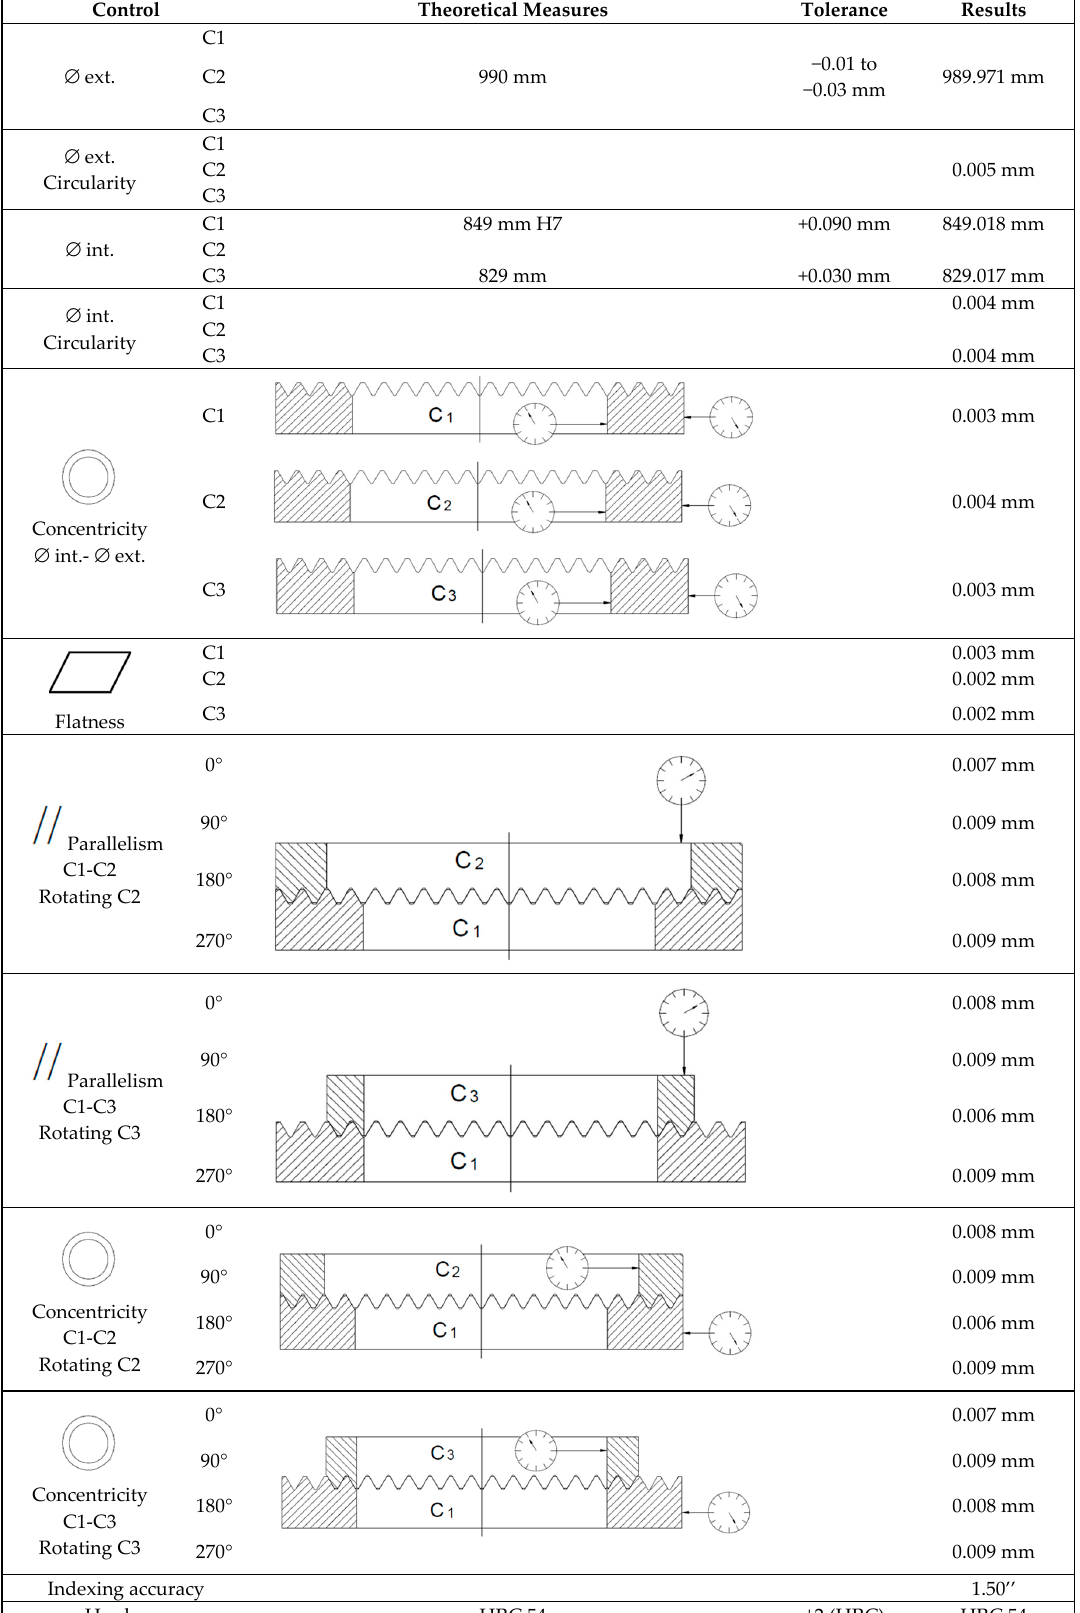
Table 3. Measuring report of Hirth rings engagements.